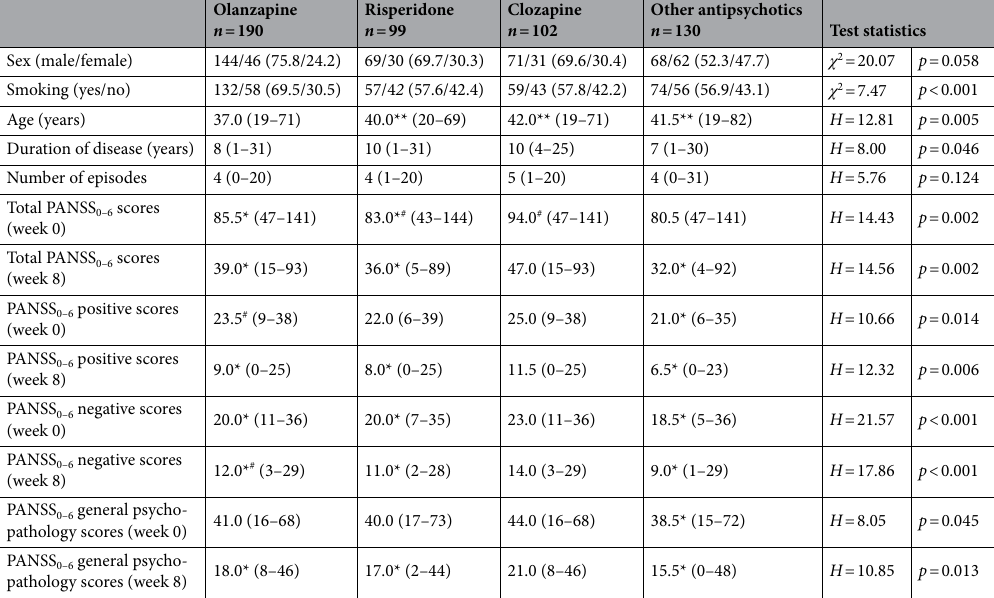
Table 1. Demographic and clinical data of 521 schizophrenic patients treated with olanzapine, risperidone, clozapine and other antipsychotics. Categorical data was analyzed with Chi-square test ( df = 2) and shown as n (%). Numerical data was analyzed with Kruskal–Wallis ANOVA ( df = 3) test and shown as median (range). n number of subjects, PANSS positive and negative syndrome scale. * p < 0.05 vs. clozapine; # p < 0.05 vs. other antipsychotics; ** p < 0.05 vs. olanzapine (Dunn’s